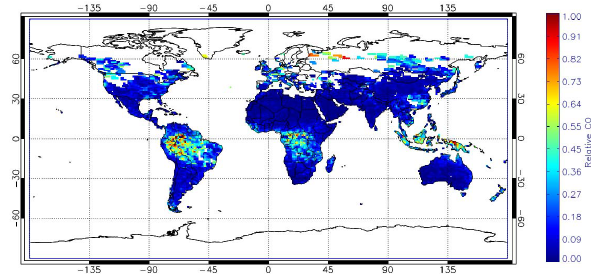
Fig. 6. Relative difference [(VCD corrected - VCD uncorrected )/VCD uncorrected ] of SCIAMACHY CO column densities with and without cloud correction (January 2004). Especially over regions with high cloud top heights the neglect of the cloud correction can lead to large errors even for rather small cloud fractions (here only observations with effective cloud fraction <20% are considered; white areas indicate missing values).